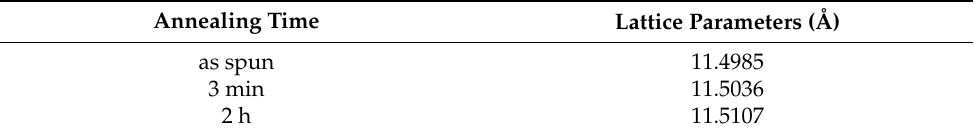
Table 3. Lattice parameters of annealed LaFe 11.5 Si 1.5 C 0.2 ribbons at 1273 K for different times.